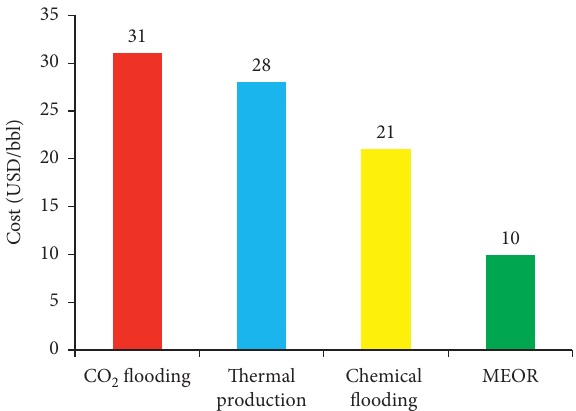
Figure 12: Estimated costs of different EOR